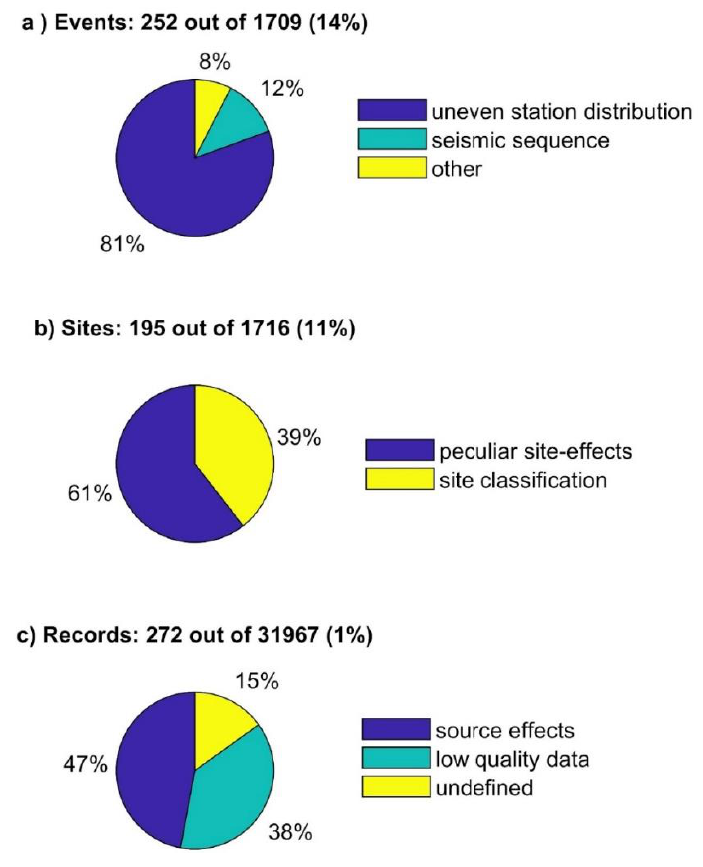
Figure 10. Statistics computed after manual revision of the peculiar events ( a ), sites ( b ) and records ( c ).